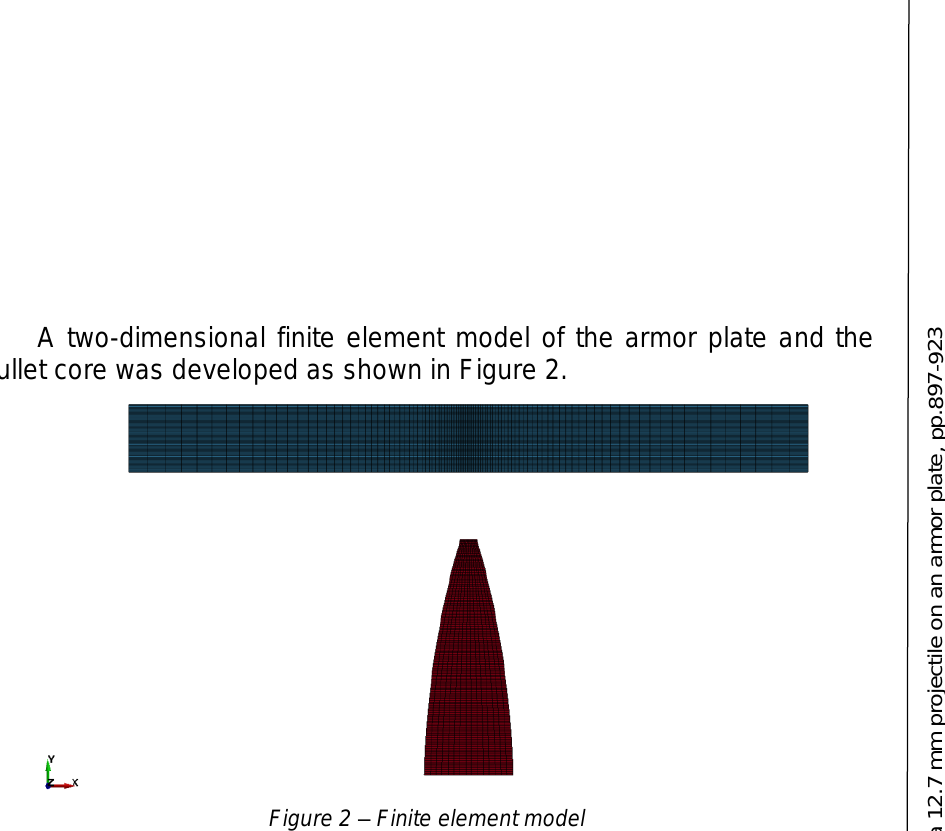
Figure 2 – Finite element